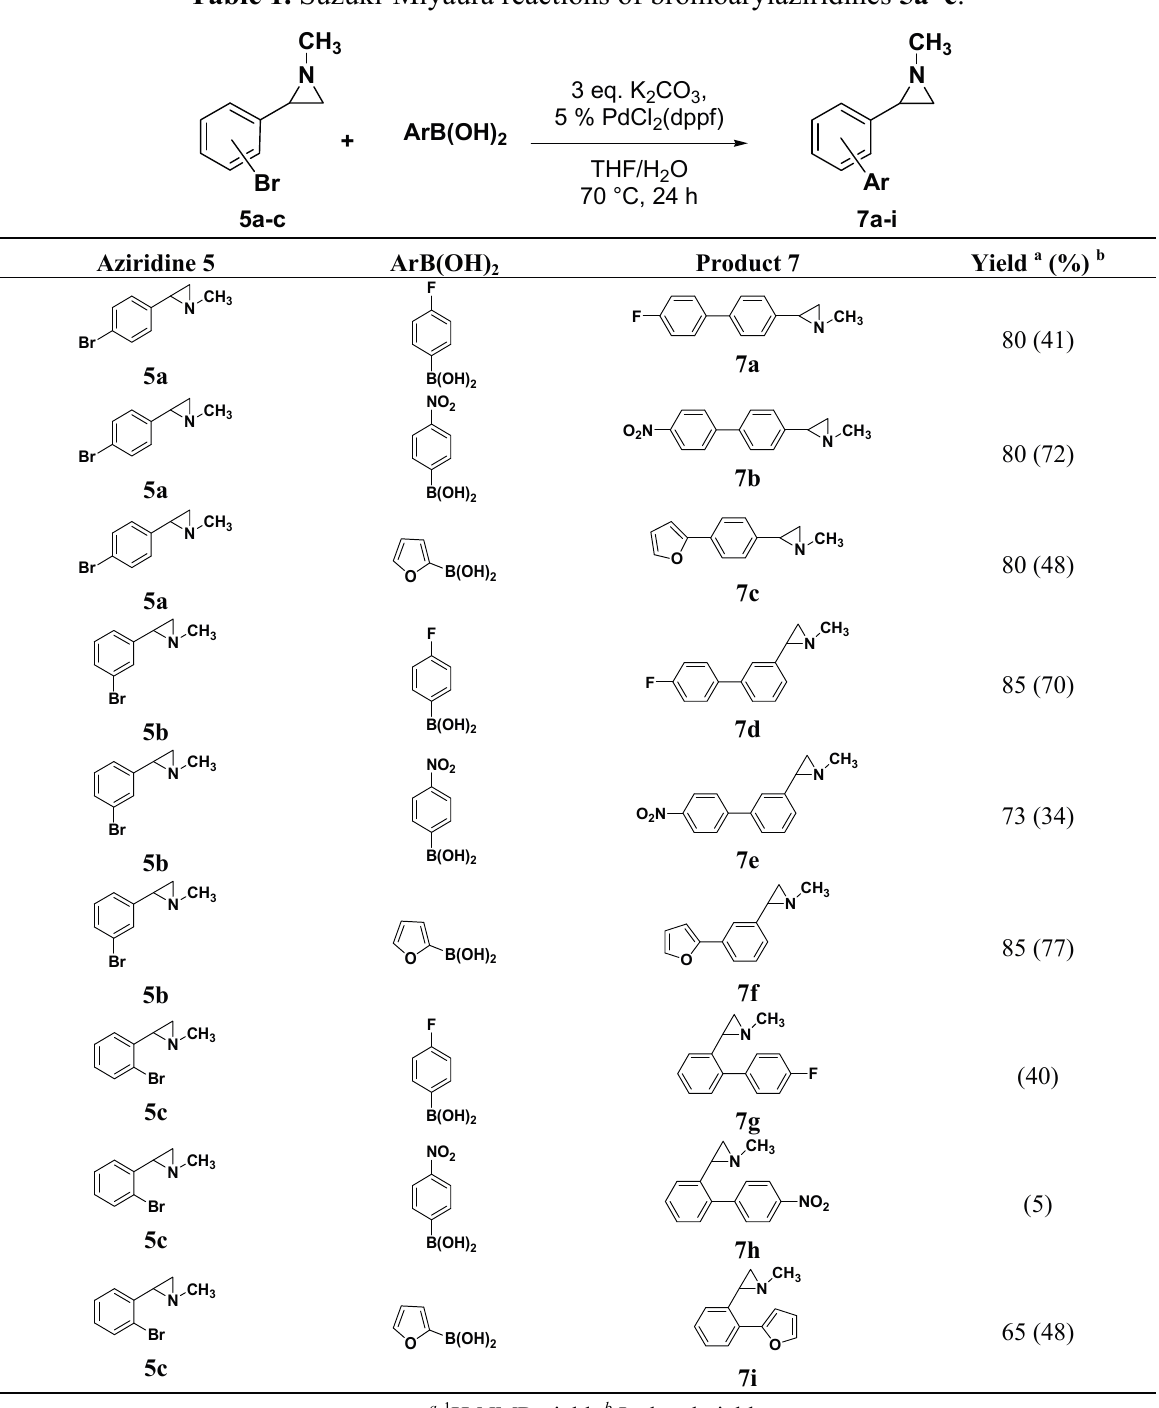
Table 1. Suzuki-Miyaura reactions of bromoarylaziridines 5a – c